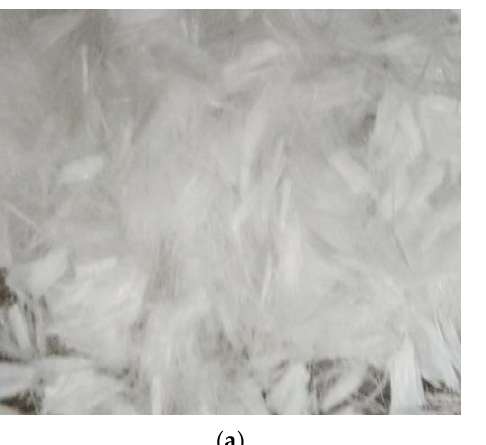
Figure 1. Morphology of ACSW: ( a ) macro-morphology, and ( b ) micro-morphology.